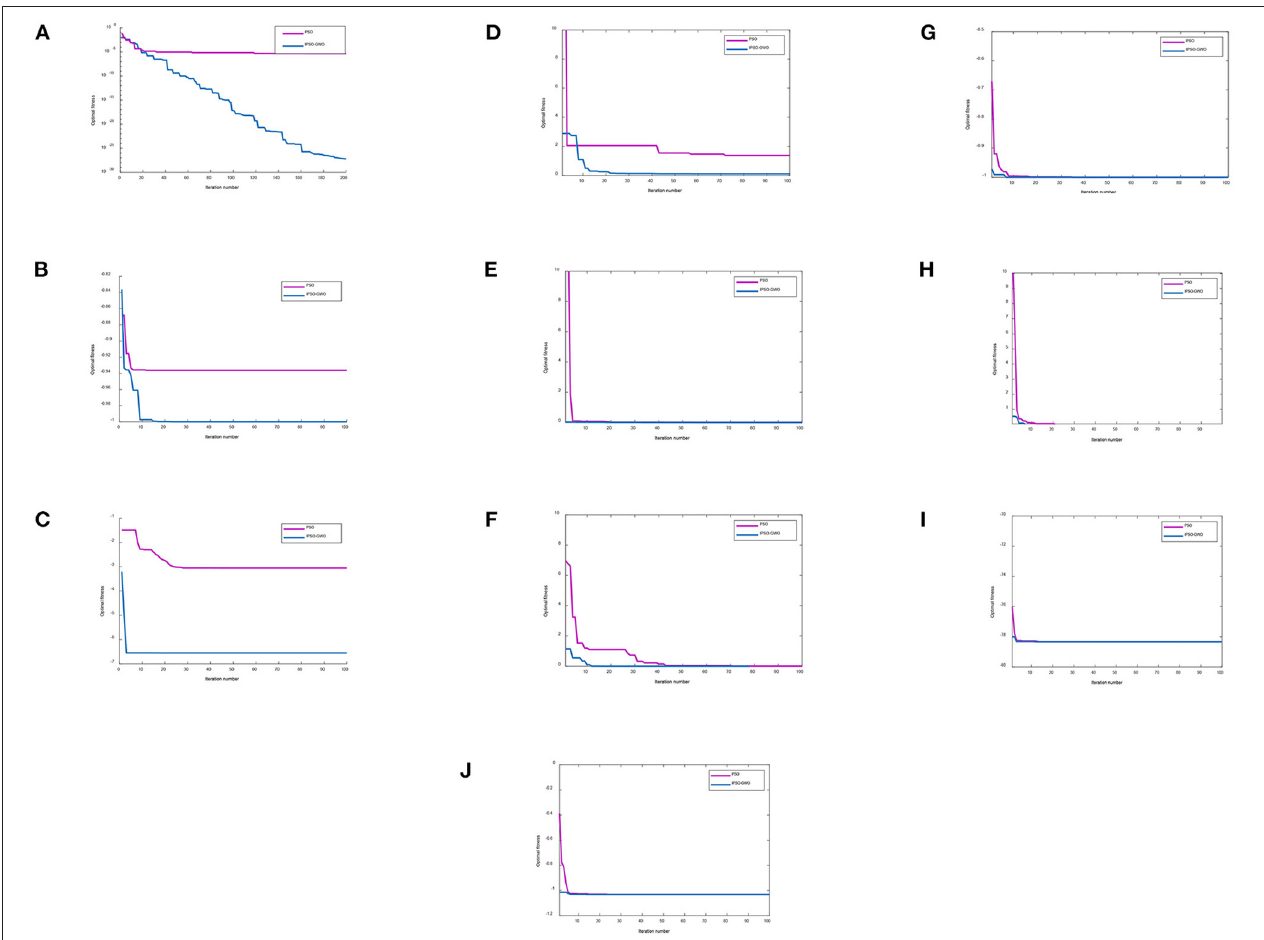
FIGURE 3 | Iteration comparison curves with different functions. (A) Iteration curve comparison diagram with Rosenbrock function. (B) Iteration curve comparison diagram with Drop Wave function. (C) Iteration curve comparison diagram with Peaks function. (D) Iteration curve comparison diagram with Bukin function. (E) Iteration curve comparison diagram with Booth function. (F) Iteration curve comparison diagram with Rastrigin function. (G) Iteration curve comparison diagram with Easom function. (H) Iteration curve comparison diagram with Levy function. (I) Iteration curve comparison diagram with Styblinski-Tang function. (J) Iteration curve comparison diagram with Six-Hump Camel